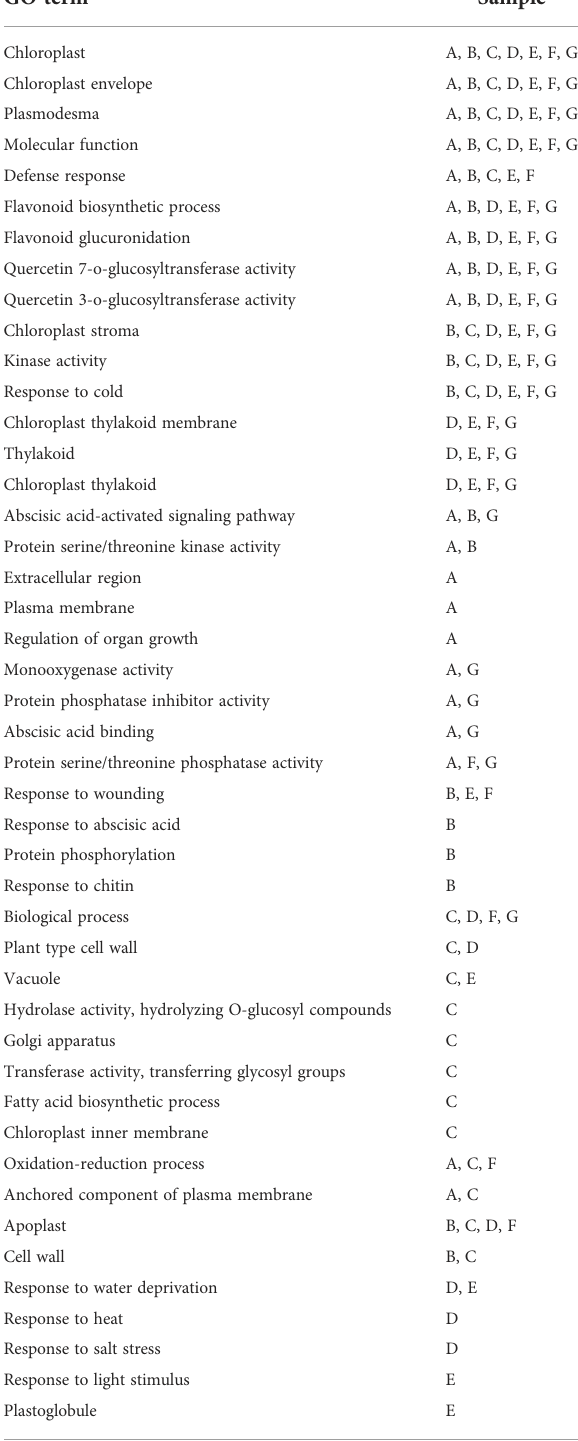
TABLE 3 GO enrichment analysis of DEGs across genotypes and developmental stages in tree